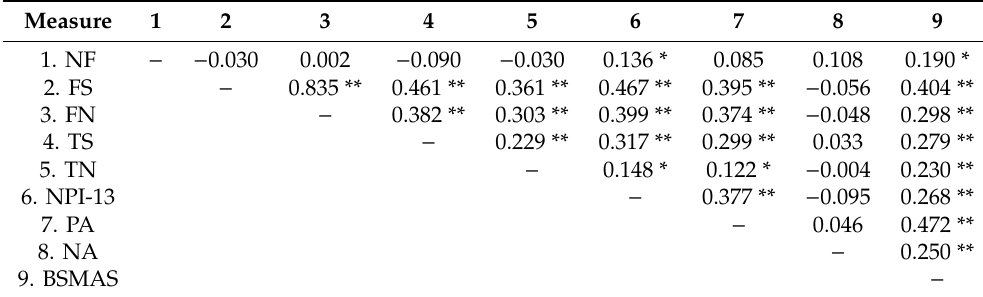
Table 1. Correlations for scores of NPI-13, PANAS, BSMAS and Social Media Use.